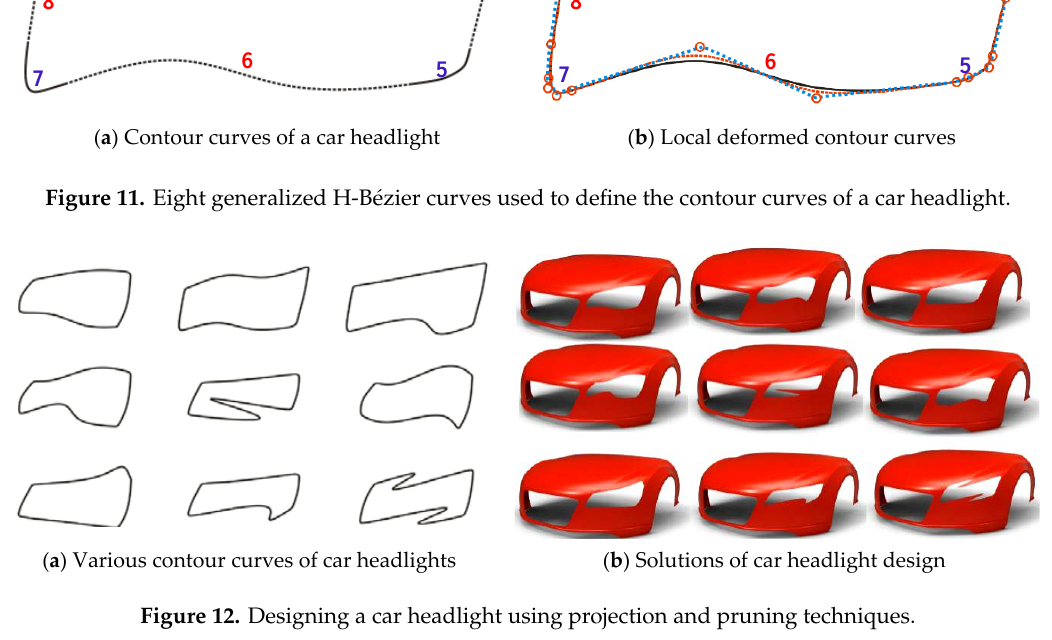
Figure 12. Designing a car headlight using projection and pruning techniques.